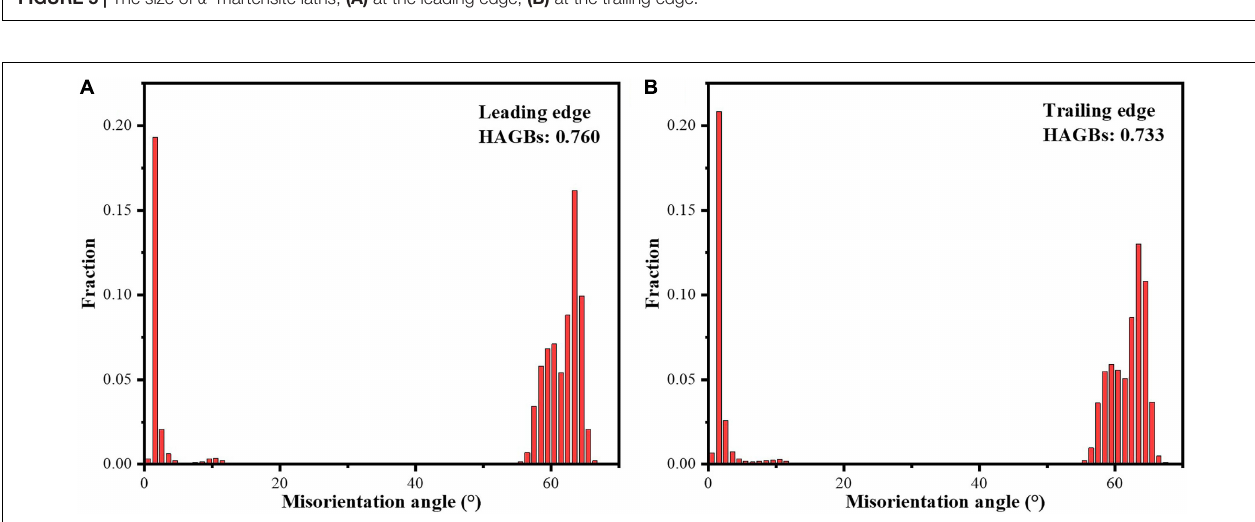
FIGURE 5 | The size of α (cid:48) martensite laths, (A) at the leading edge, (B) at the trailing edge.